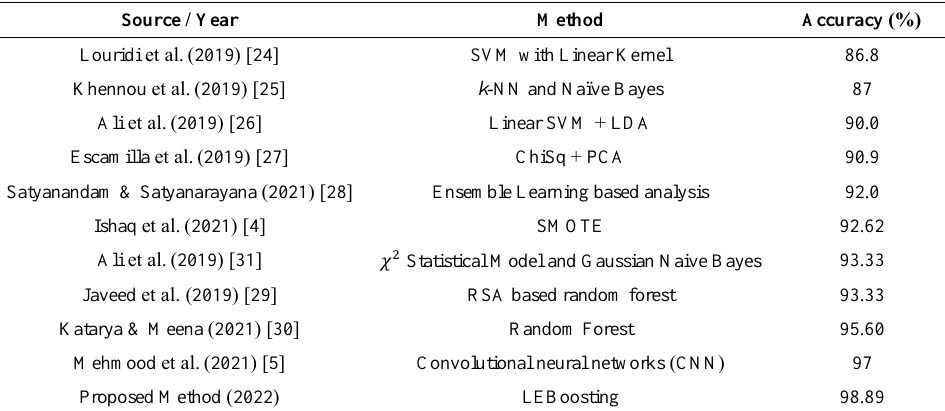
Table 7. Comparison of efficacy with other